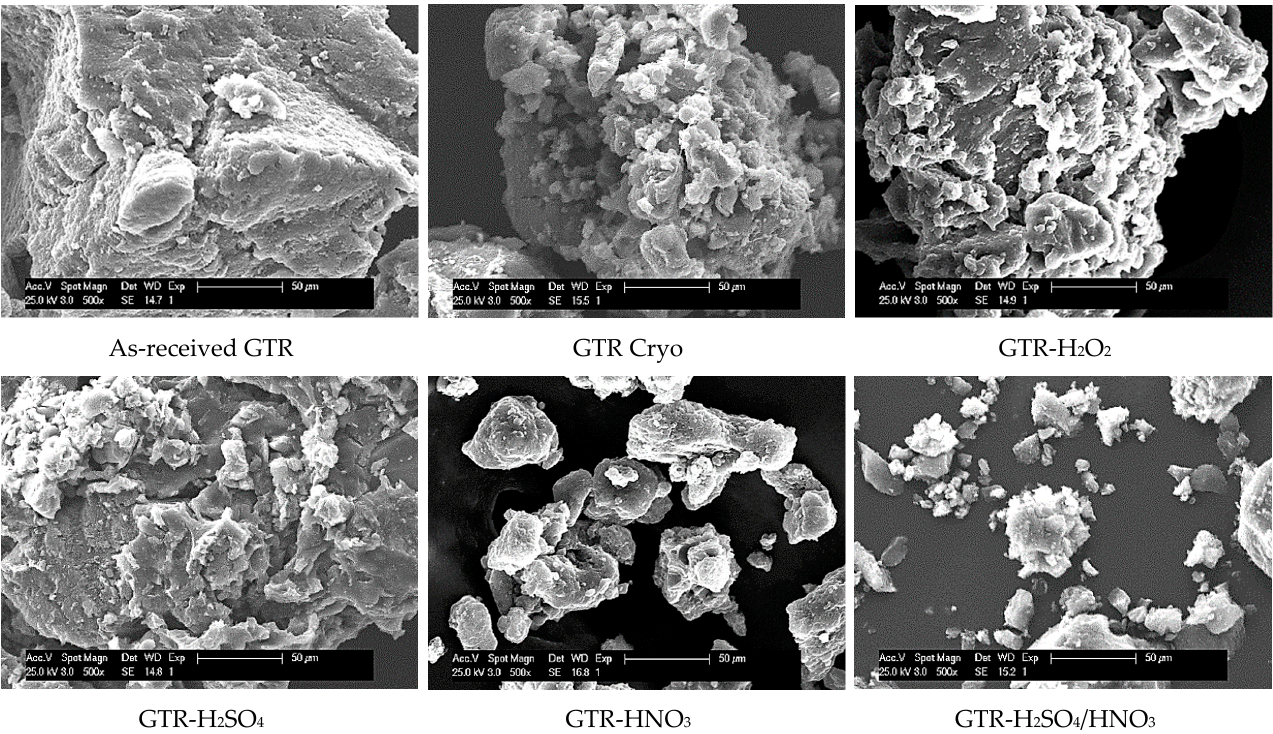
Figure 2. Scanning electron microscope (SEM) micrographs of GTR and modified GTR (m-GTR) with different treatments at a magnification of 500×.